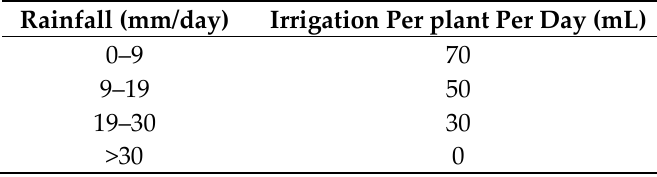
Table 2. Irrigation requirement of Eucalyptus pellita during early growth, based on rainfall